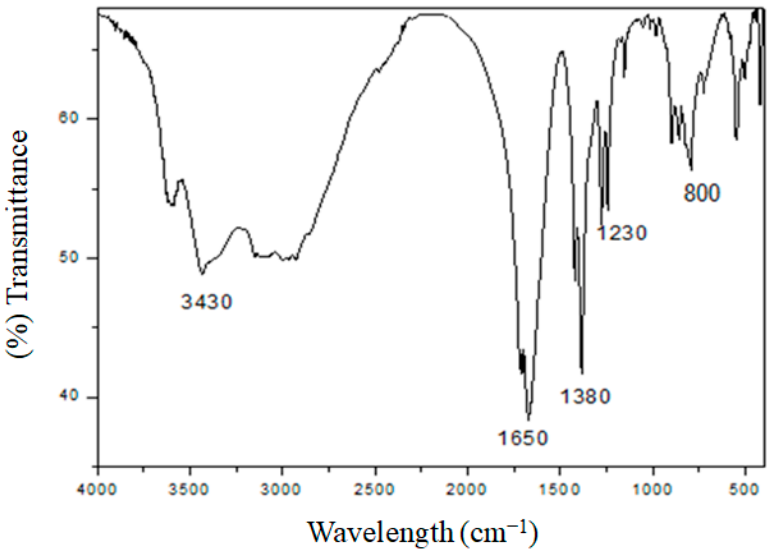
Figure 2. FT − IR spectrum of the AgNPs from Aeonium haworthii leaf extract.